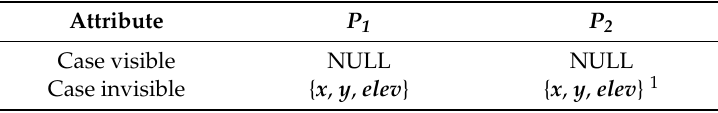
Table 1. The structure of the new auxiliary